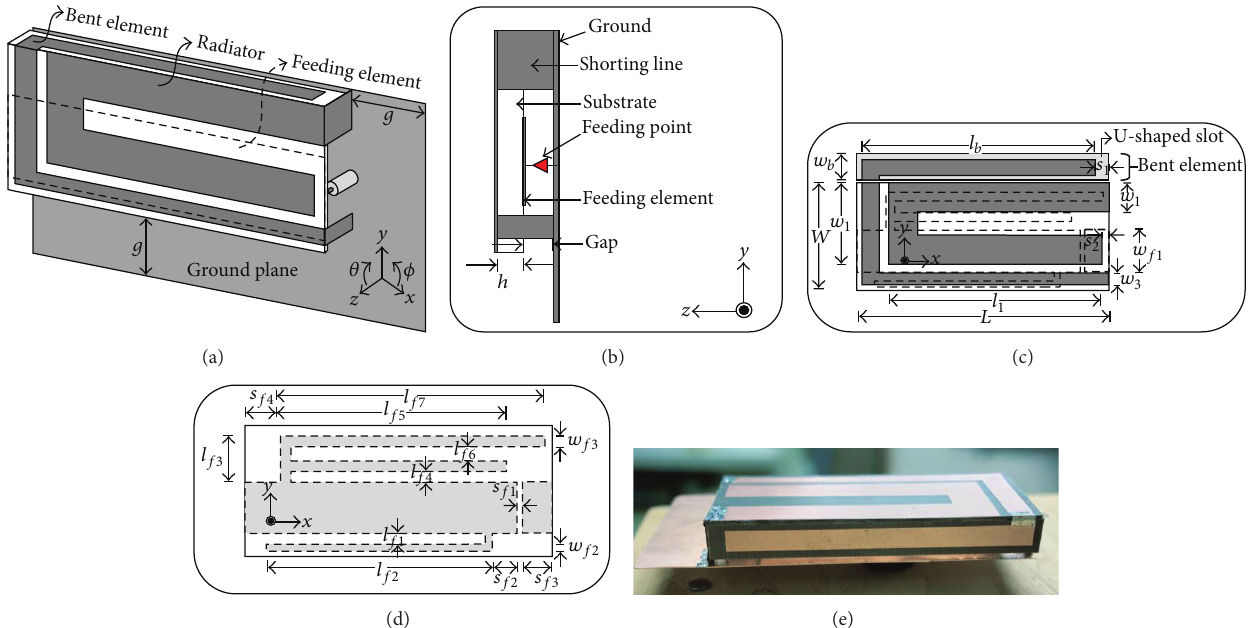
Figure1:Geometryoftheproposedantenna.(a)Perspectiveview,(b)sideview,(c)radiatingelement,(d)feedingelement,and(e)photograph of the fabricated